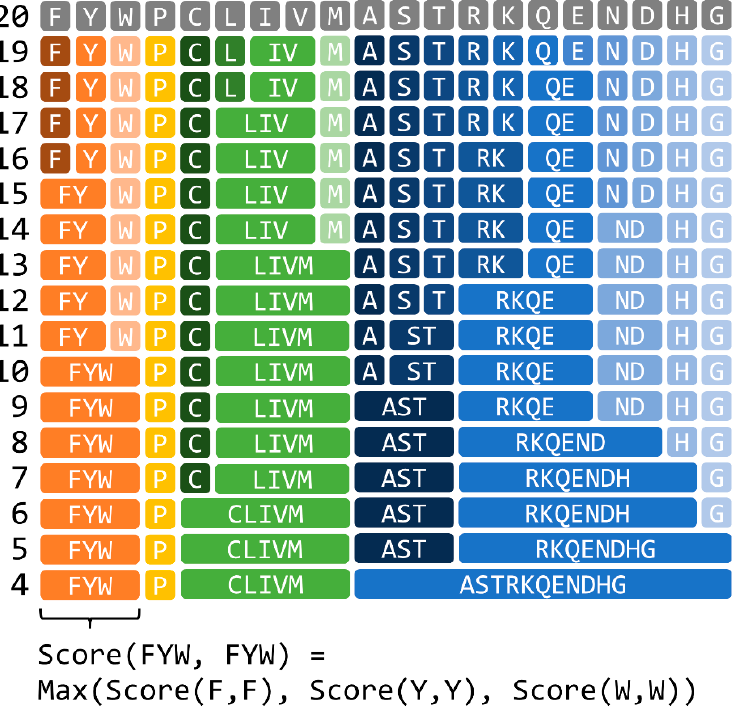
Seed search steps of